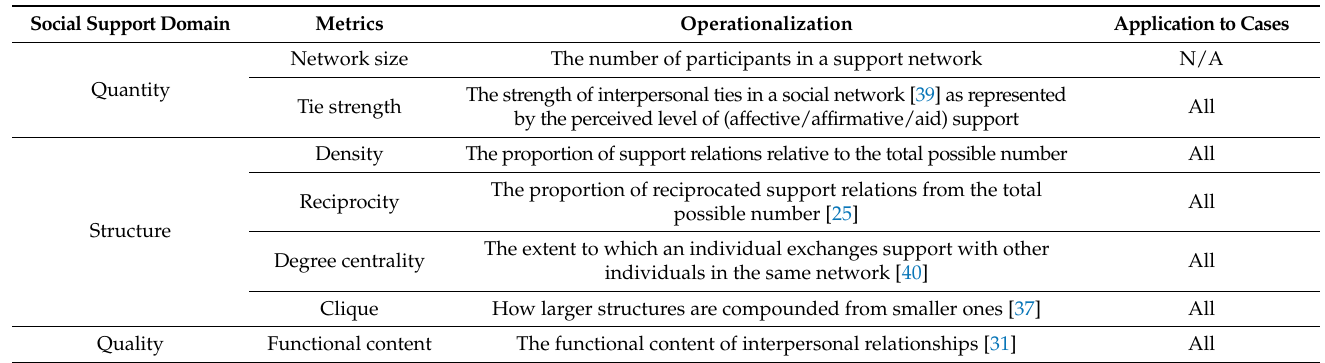
Table 2. Metrics for measuring peer